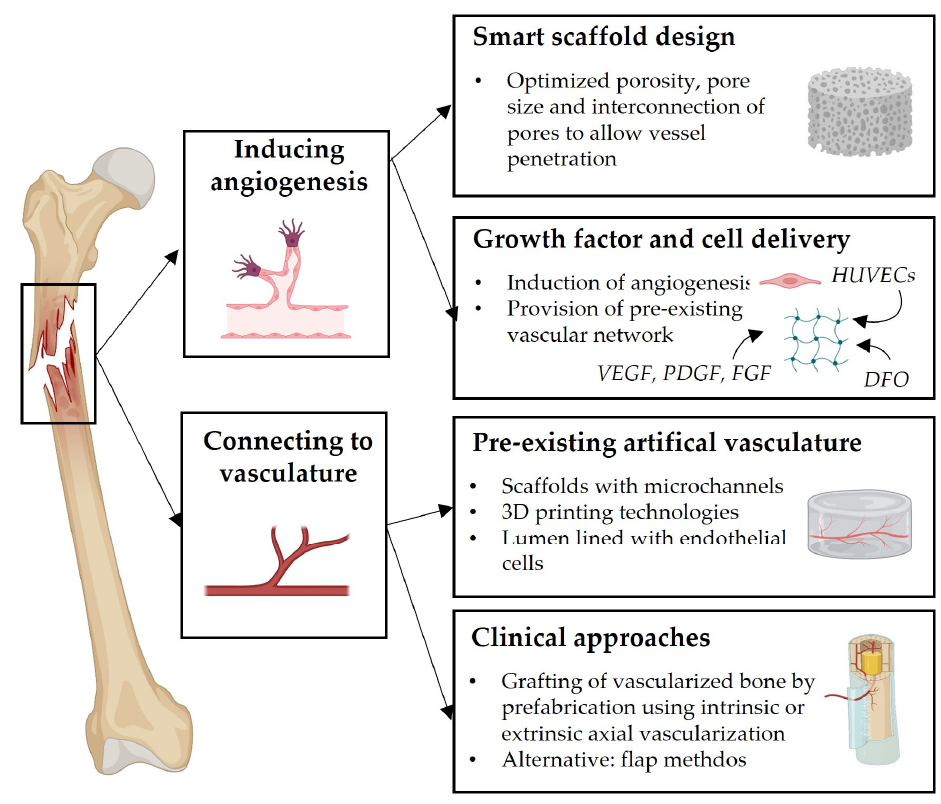
Figure 4. Overview on current vascularization strategies for scaffold guided bone regeneration. Figure contains illustrations and icons created with BioRender.com (accessed on 8 December 2022).